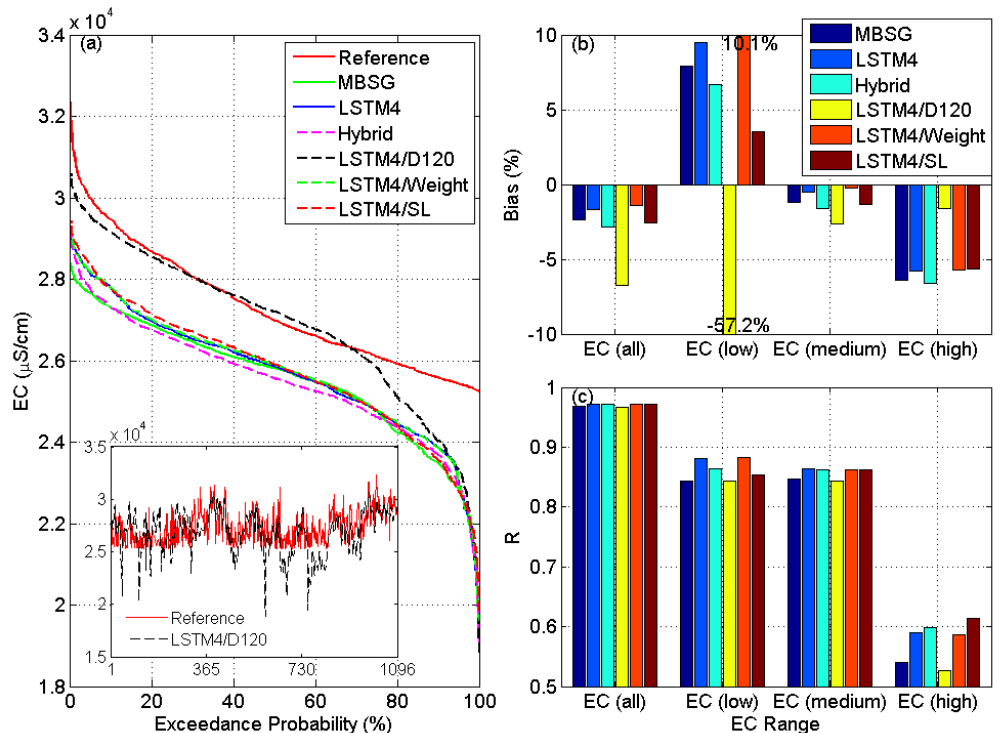
Figure 10. ( a ) Exceedance probability curves of the reference high range salinity at Martinez and corresponding simulations generated via MBSG, LSTM4, hybrid model, and three additional LSTM models (LSTM / D120, LSTM4 / Weight, and LSTM4 / SL). The insert figure shows time series plot of the reference high range salinity and the corresponding simulations from LSTM4 / D120. ( b ) Correlation between reference salinity and simulated salinity via different models shown in ( a ). ( c ) Percent bias between reference and simulated salinity across different salinity ranges (low, medium, high, and all together).